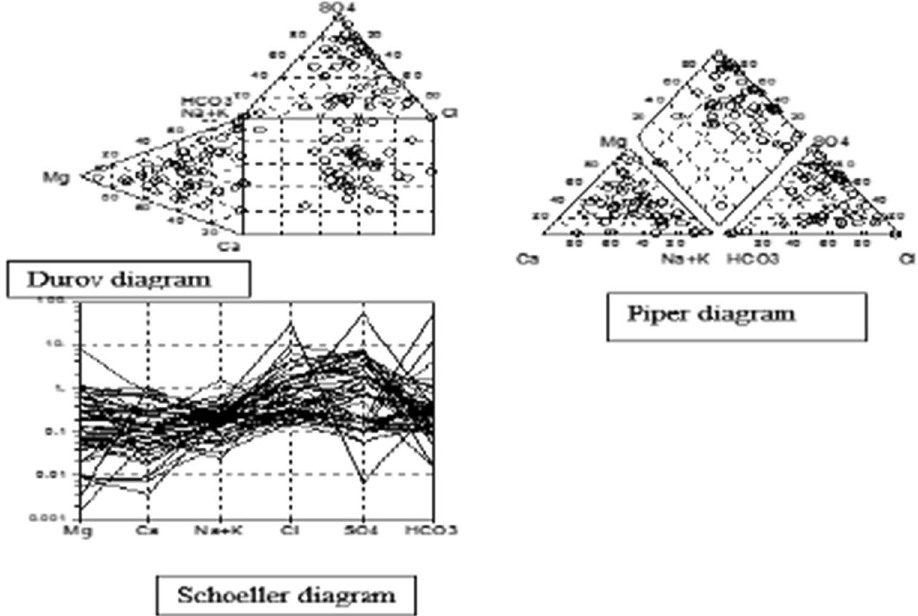
Fig. 4 Diagrammatical